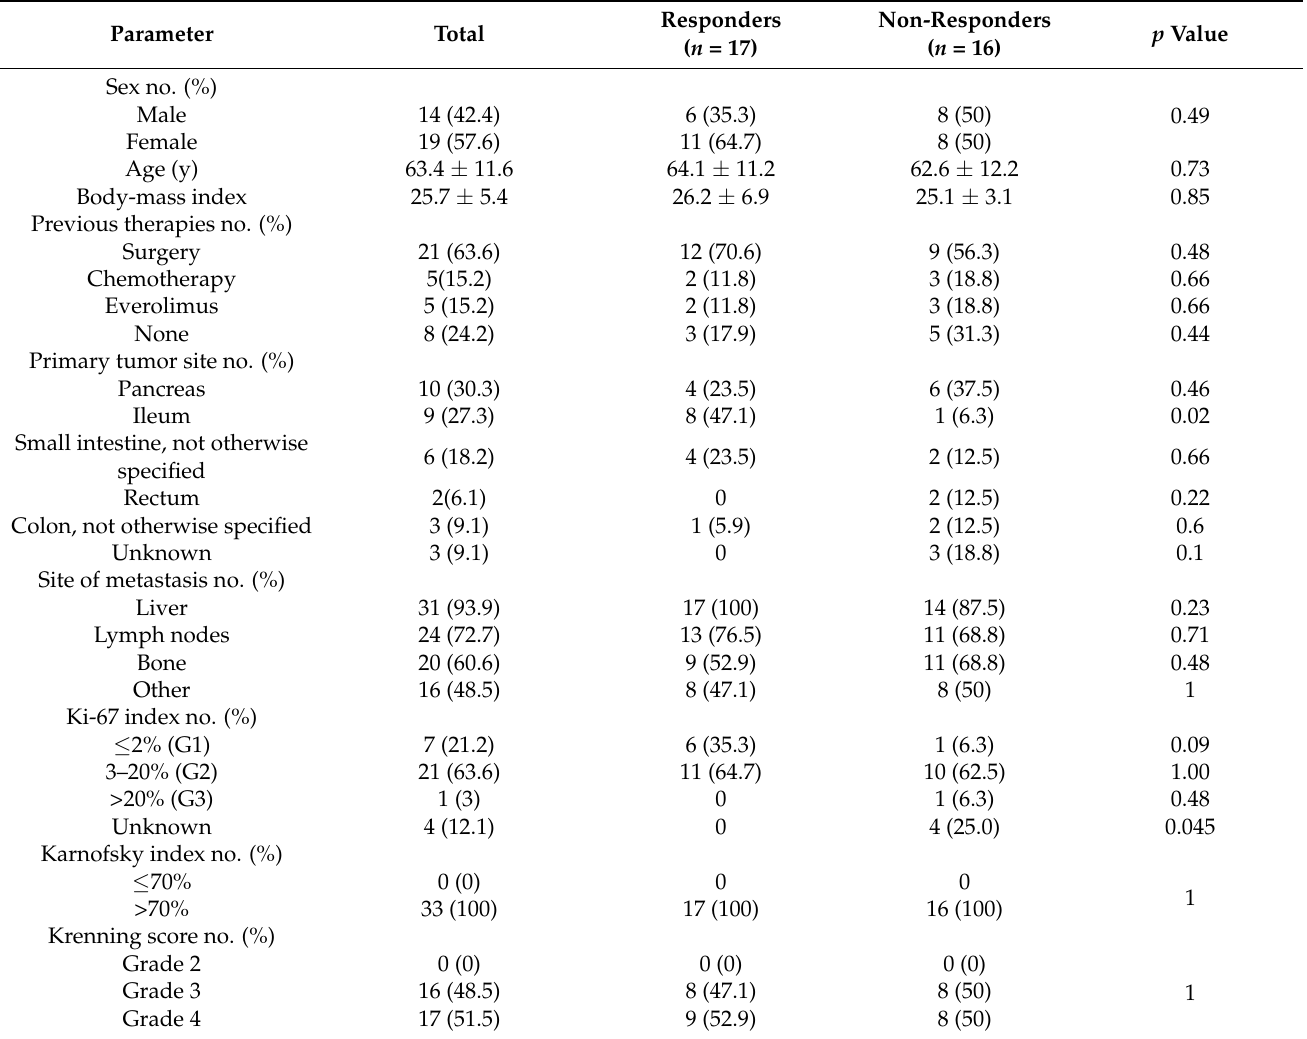
Table 1. Characteristics of study population ( n =